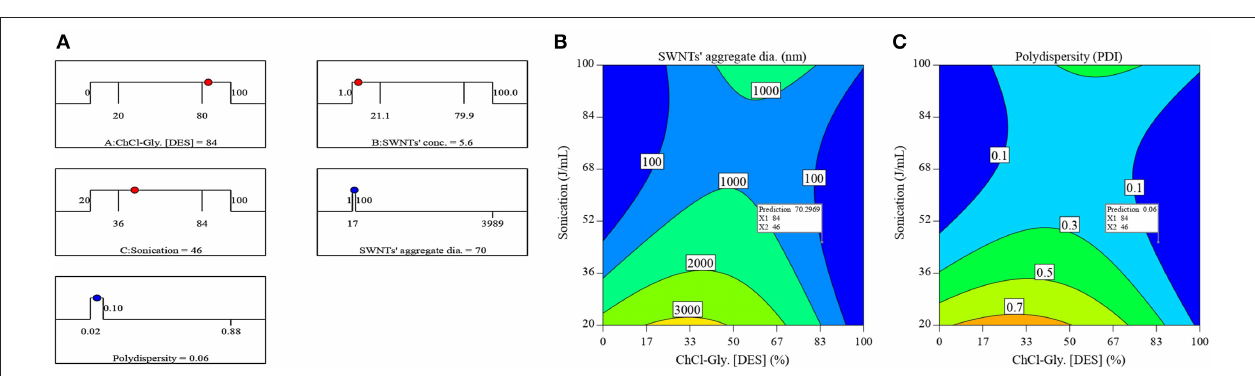
FIGURE 6 | Optimization of SWNTs’ dispersion in aqueous ChCh-Gly system. (A) The ramp plot indicates the position of factors (red dots) and responses (blue dots) at optimized positions. Optimum (B) SWNTs’ aggregate diameter (70.3nm) and (C) polydispersity (0.06) can be located by the position of flags.